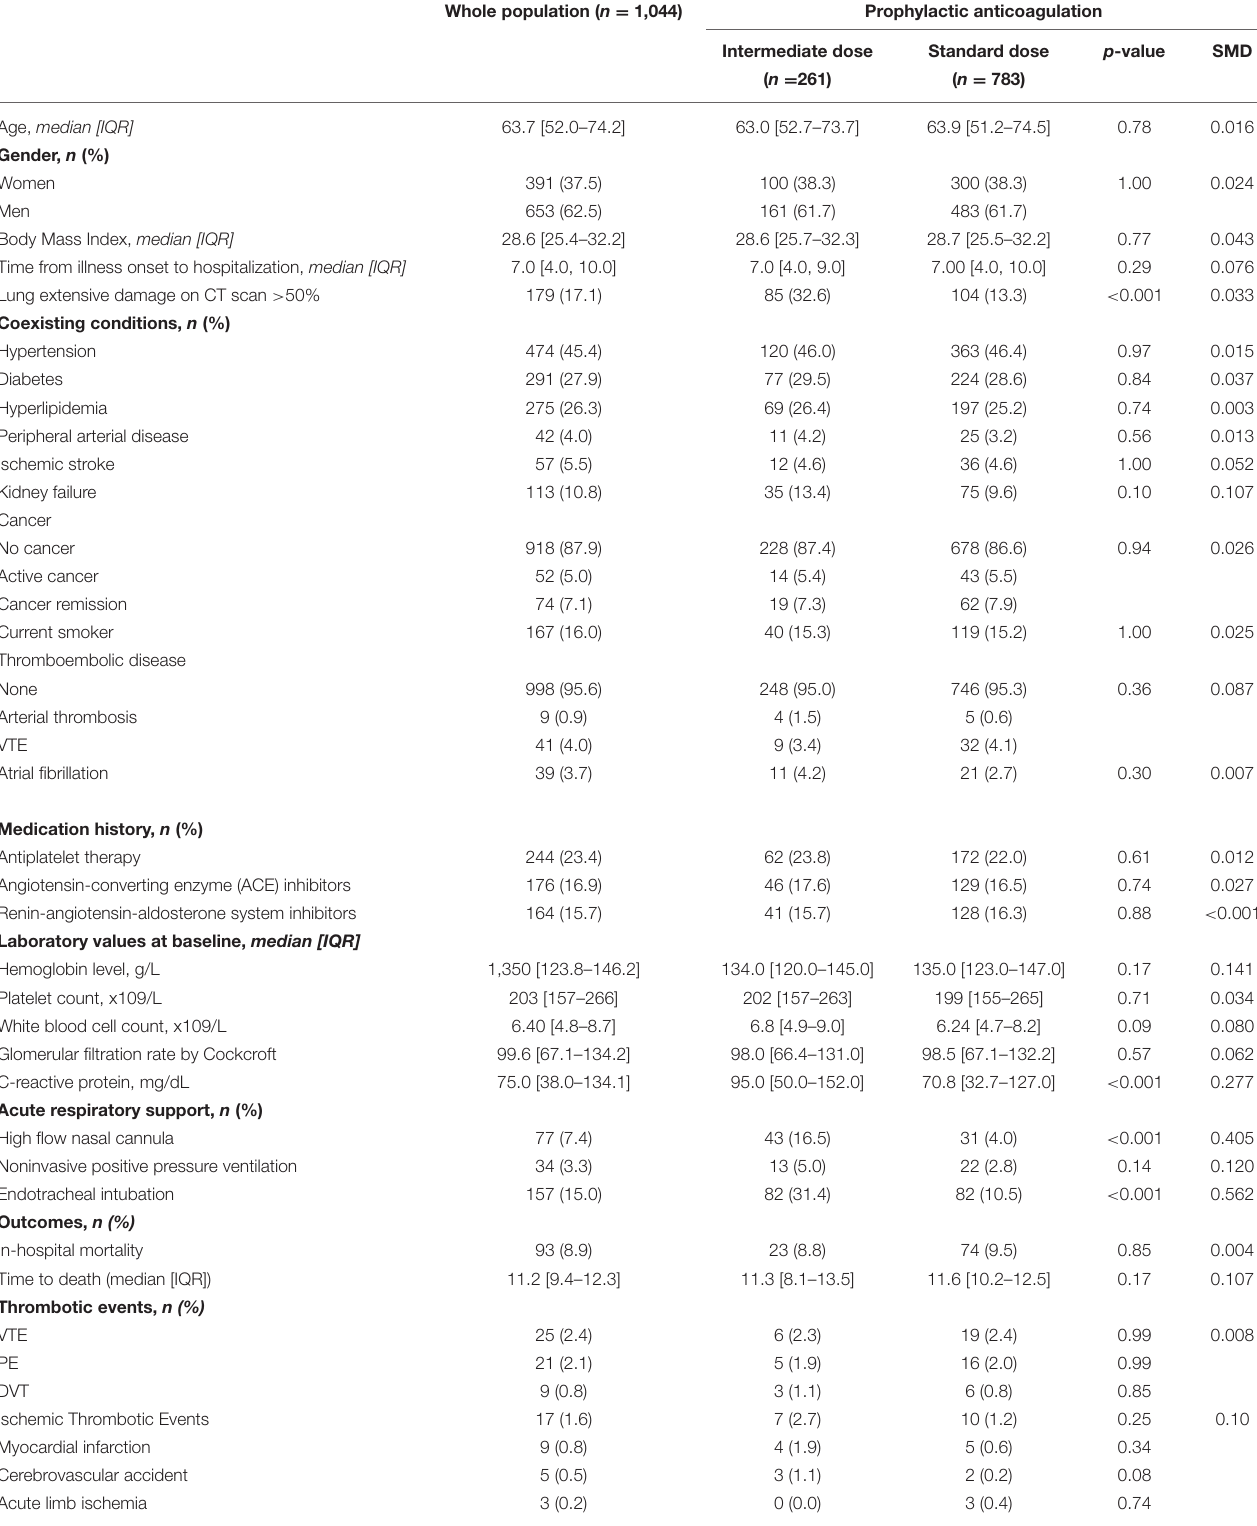
TABLE 1 | Baseline characteristics of the matched population between intermediate- vs. standard-dose prophylactic anticoagulation among patients with COVID-19 admitted in medical